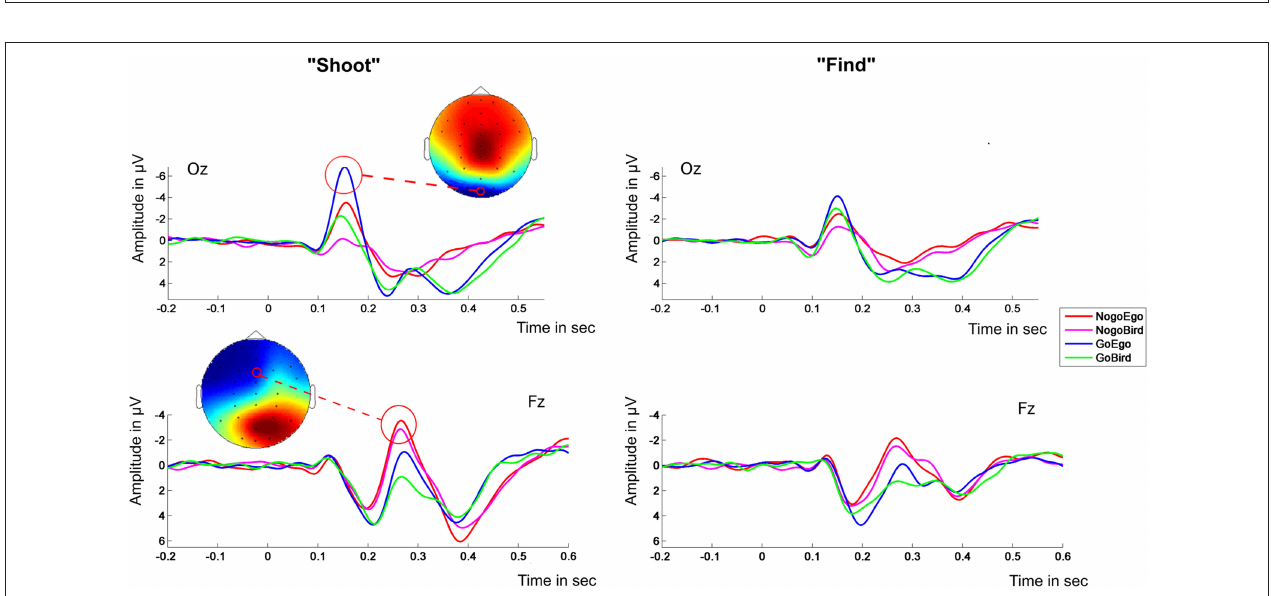
FIGURE 2 | Time-frequency analysis. Pre-stimulus alpha power over occipital and parietal electrodes for both the “shoot” condition (left part) and the “detect” condition (right part). Alpha power was significantly reduced in the Ego condition of the “shoot” task. Upmost panel: Ego condition. Middle panel: Bird condition. Lowest panel: Contrast Bird—Ego Condition. Warm colors indicate higher alpha power.